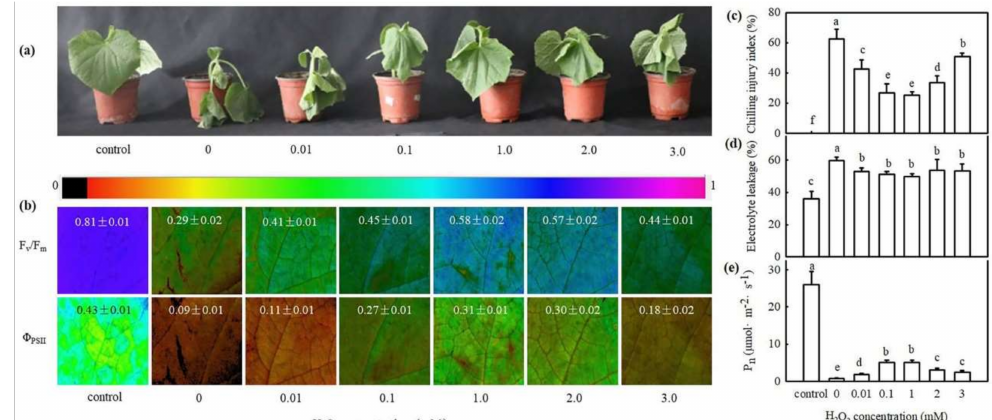
Figure 1. Effect of H 2 O 2 on the chilling tolerance of cucumber seedlings. ( a ) Phenotype characterization of cucumber seedlings pretreated with H 2 O 2 or deionized water under chilling stress (8/5 ◦ C) for 48 h. Deionized water-treated seedlings before chilling stress were used as the control. The experiments were repeated three times with similar results. A typical picture is shown here. ( b ) Image of F v /F m and Φ PSII in seedlings before (control) and after chilling stress for 24 h. The false color code depicted at top of the image represents the degree of photoinhibition at PSII. ( c ) CI of seedlings before (control) and after chilling stress for 72 h. ( d ) EL of seedlings before (control) and after chilling stress for 48 h. ( e ) Pn of seedlings before (control) and after chilling stress for 24 h. Two-leaf stage cucumber seedlings were foliage sprayed with 0, 0.01, 0.1, 1.0, 2.0 and 3.0 mM H 2 O 2 solution for 24 h and subsequently were exposed to 8/5 ◦ C (day/night). The data represent the mean ± SD of three biological replicates. Different letters indicate significant differences ( p < 0.05), according to Duncan’s new multiple range